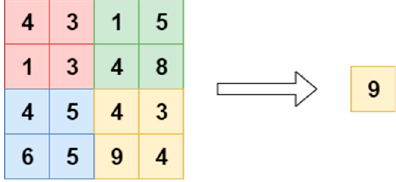
Figure 2. 2 × 2 average pooling with stride 2.